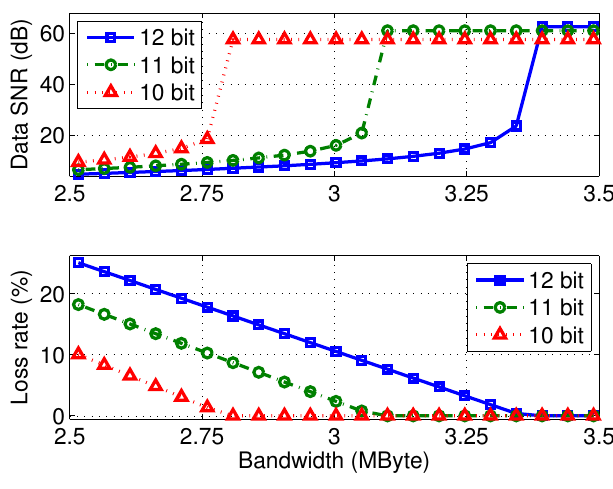
Figure 8. Data SNR and packet drop rates with different data bit